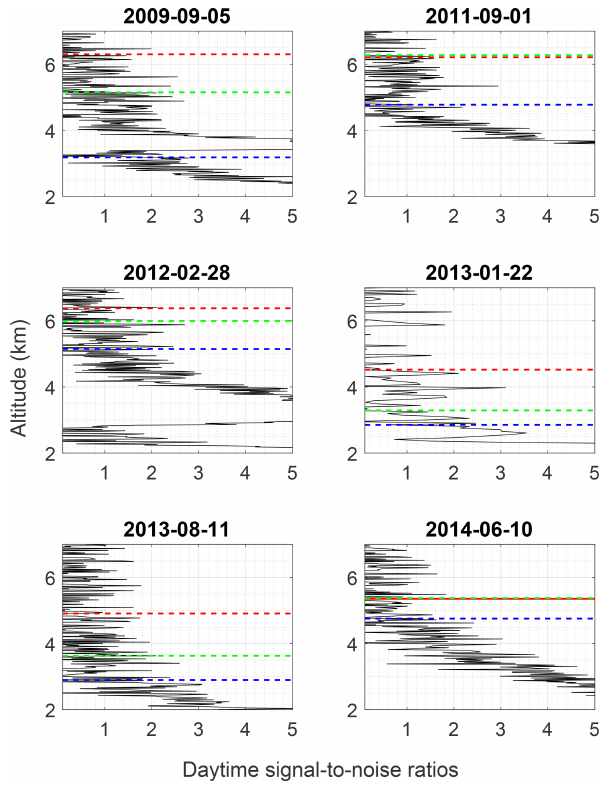
Figure 8. Daytime water vapor SNRs (black). The various cutoff heights are shown in dashed lines. The 0.9 measurement response cutoff is blue, the 0.8 measurement response cutoff is green, and the coarse-grid cutoff is in red.